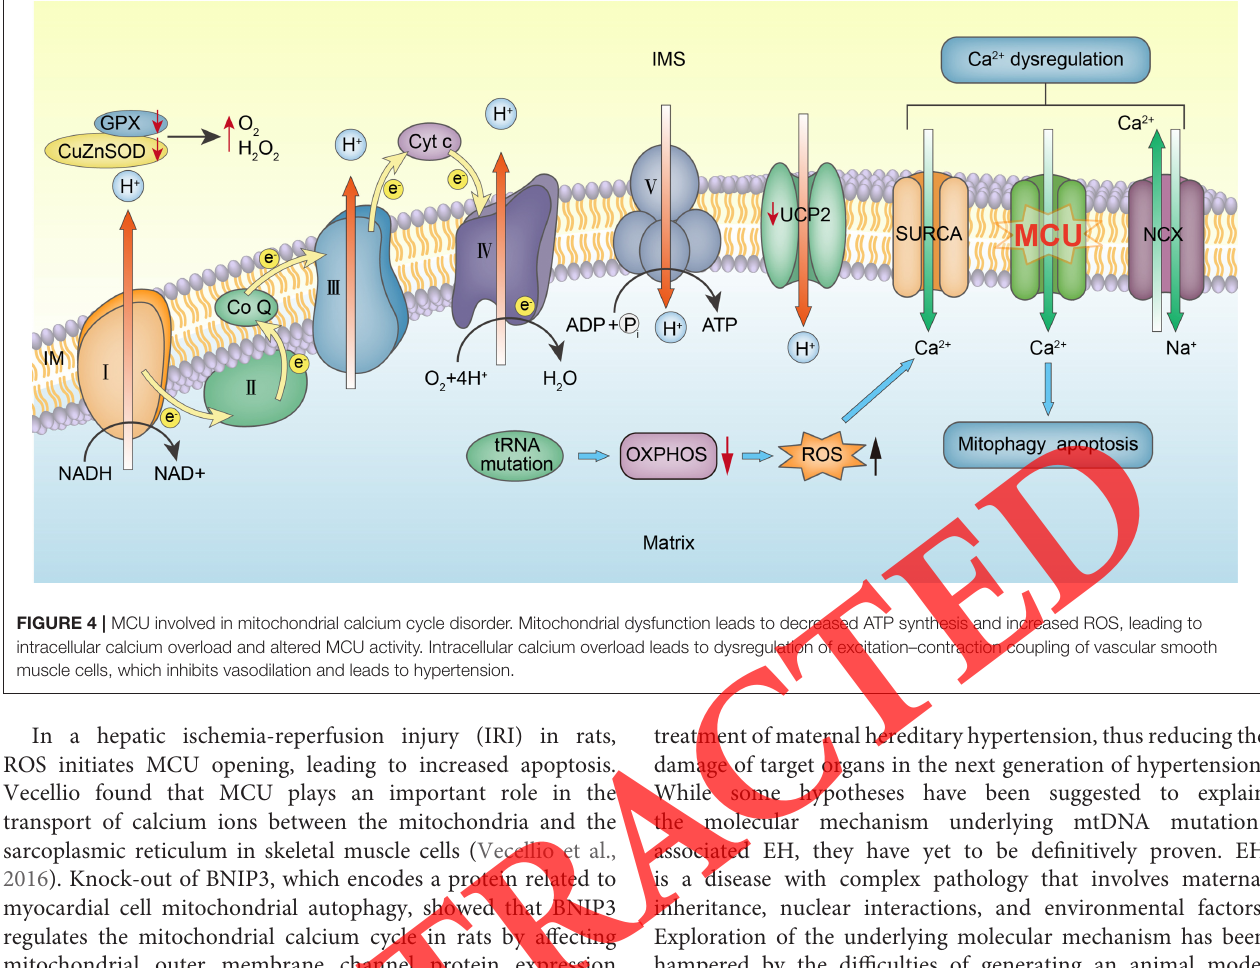
FIGURE 4 | MCU involved in mitochondrial calcium cycle disorder. Mitochondrial dysfunction leads to decreased ATP synthesis and increased ROS, leading to intracellular calcium overload and altered MCU activity. Intracellular calcium overload leads to dysregulation of excitation–contraction coupling of vascular smooth muscle cells, which inhibits vasodilation and leads to